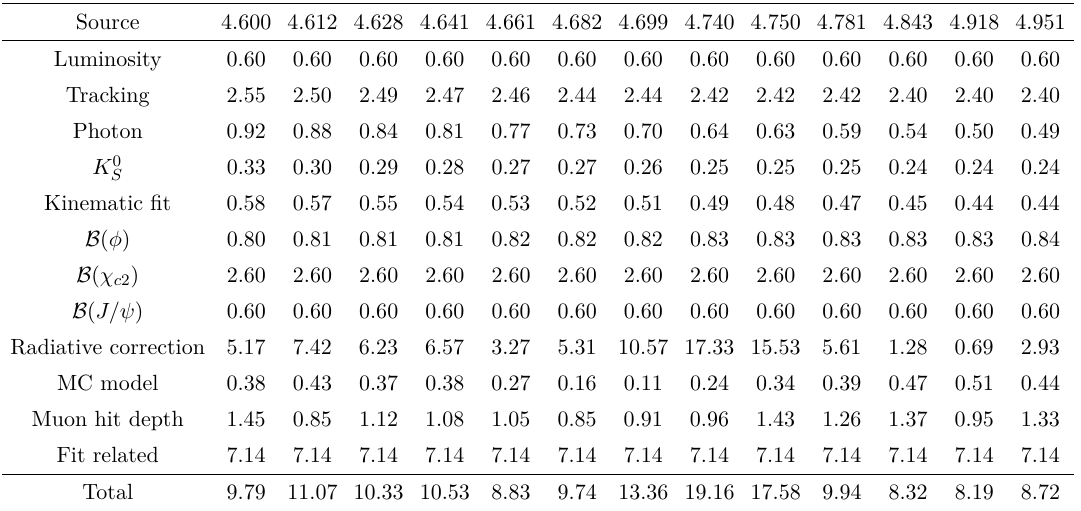
Table 14 . The systematic uncertainties (in %) for e + e − → φχ c 2 cross sections at each energy